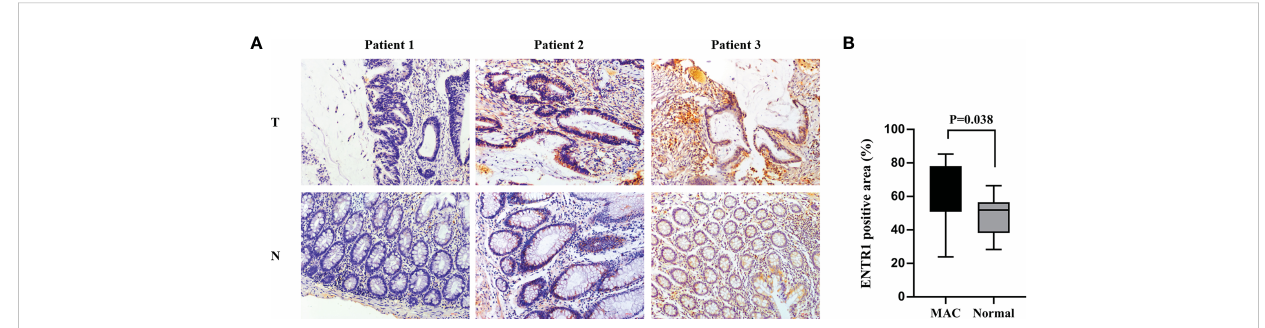
FIGURE 8 Validation of ENTR1 expression. (A) Immunohistochemistry of ENTR1 expression in tumor tissues (T) and corresponding normal tissues (N) of 3 patients with MAC (x200). (B) The proportion of ENTR1 positive area in tumor tissues of MAC and the corresponding normal tissues (immunohistochemistry, n = 13). MAC, mucinous